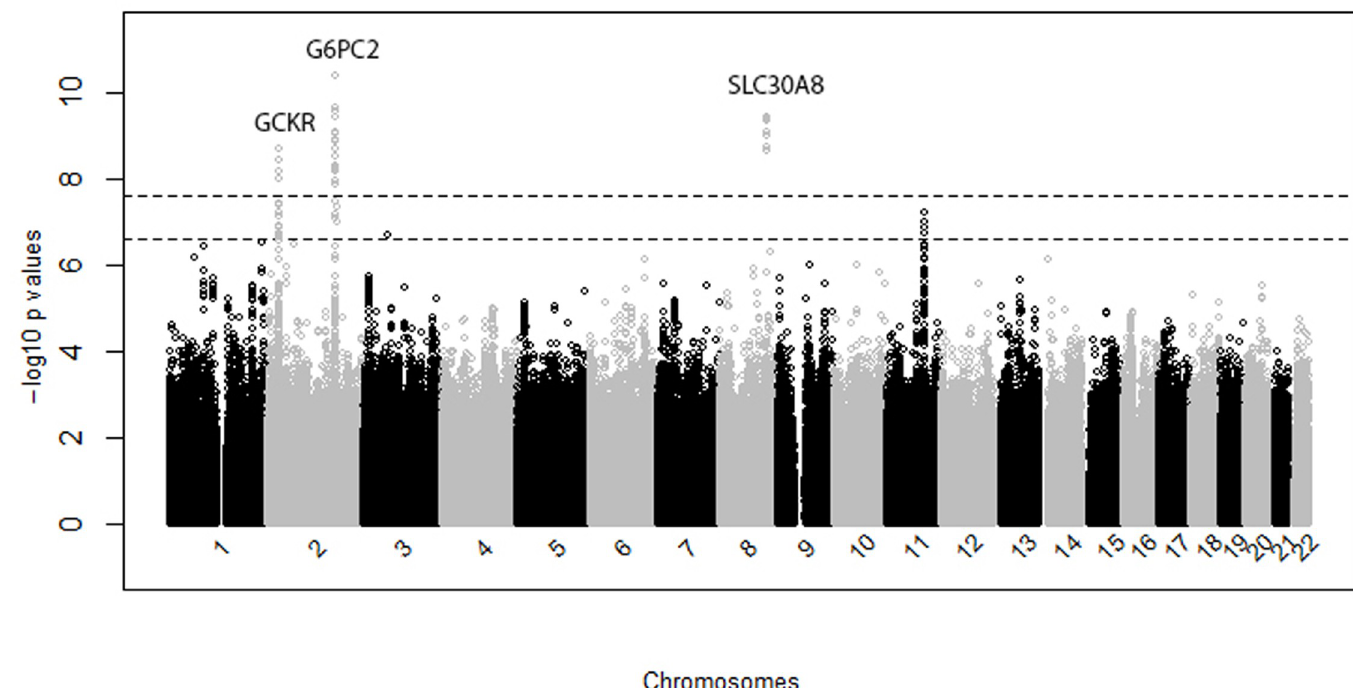
Fig 1. Manhattan plot for discovery analysis based on individuals with European ancestry. The x -axis represents chromosomal positions, and the y -axis represents -log 10 ( p -value). The two dotted lines represent -log 10 (5 × 10 − 8 ) and -log 10 (5 × 10 − 7 ), respectively. To determine a best fit model jointly across loci, the three loci and all possible interactions were specified in a full model. Regression with backward selection (SLSTAY = 0.10) was used to eliminate variables (S5 Table). The final model included the three lead SNPs without any interactions. After excluding possible interactions, we found that the effect alleles influence fasting glucose in an additive manner (Fig 4). For each copy of a T allele at any of the three SNPs, an additive effect of -0.012 mmol/L on fasting glucose was identified in the discovery sample ( p = 3.0 × 10 − 28 ) and replicated in trans-ethnic meta-analysis ( n = 14,303, β = -0.0088, SE = 0.0011, p = 2.15 × 10 − 16 , S7 Fig). We also estimated the joint additive effect of the three SNPs on the risk of T2D in a total of 28,120 individuals with ( n = 4,585) or without ( n = 23,535) T2D. The three SNPs were associated with significantly reduced T2D risk, with an odds ratio of 0.93 (95% confidence interval [0.88, 0.98], p = 0.0062, S8 Fig). Notably, none of the individuals with 6 T alleles had T2D, compared to 27% of those with 0 T alleles (Fig 5).